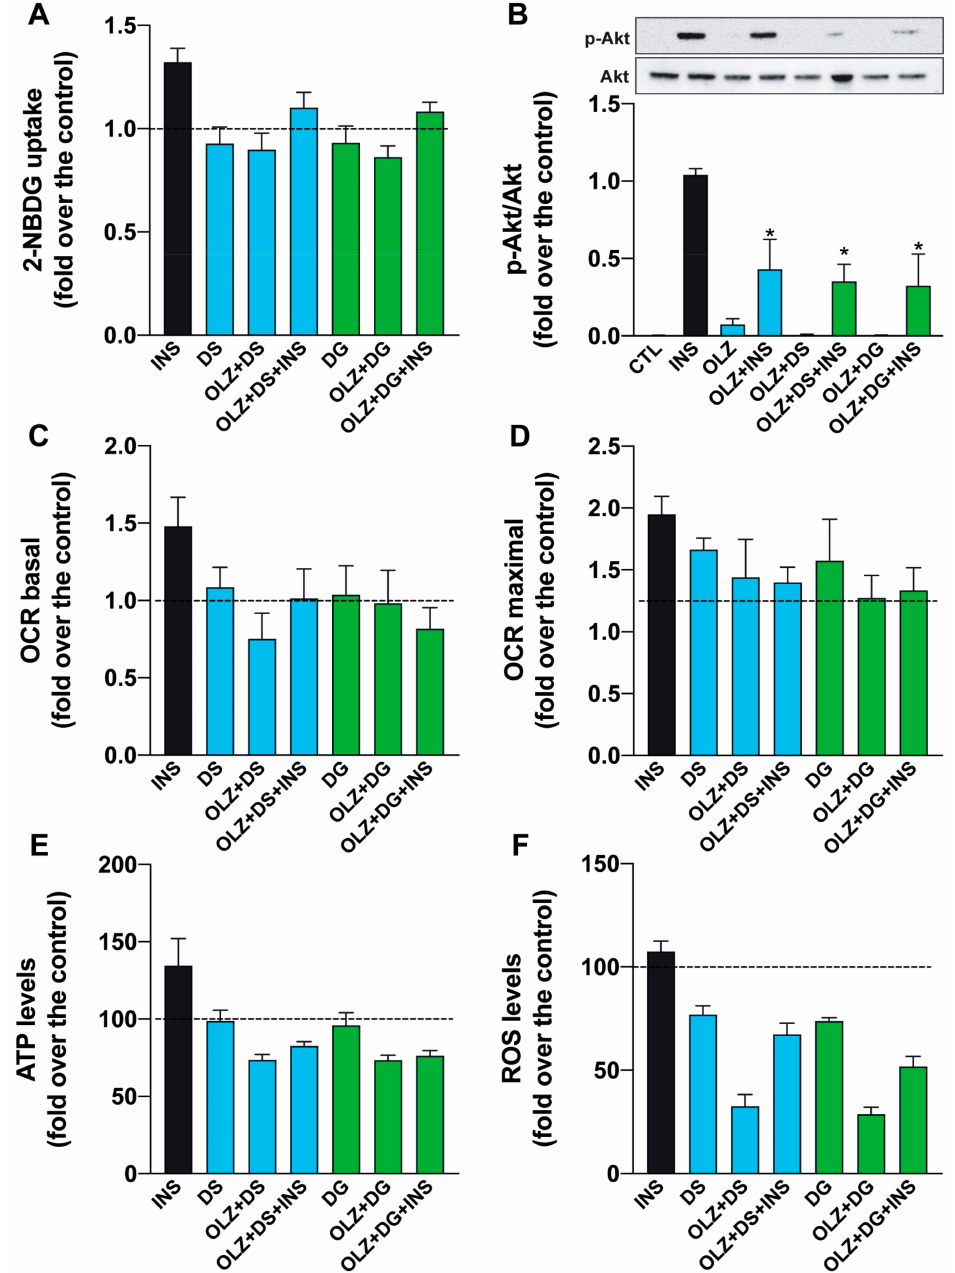
Figure 5. Effect of anthocyanins (DS and DG) co-incubated with OLZ after insulin response in L6 myoblasts. ( A ) Glucose uptake was measured after 24-h OLZ treatment in the presence (+) or absence (-) of DS or DG. Glucose uptake only increased in control cells (no treatment) after 30 min of a single 100 nM insulin stimulus (black bar). ( B ) Akt phosphorylation was determined by Western blot and normalized by total Akt to quantify differences among the conditions. OLZ treatment decreased p-Akt in response to insulin, and DS and DG co-incubation with OLZ did not restore phosphorylation levels. Mitochondrial metabolism: ( C ) Basal oxygen consumption rate (OCR) increased in L6 cells after insulin 100 nM stimuli (black bar), and incubation with anthocyanins (DS blue bars and DG green bars) decreased insulin response. ( D ) Maximal OCR was determined after the addition of FCCP to uncouple oxidative phosphorylation. ( E ) ATP levels were significantly decreased in the presence of OLZ and could not be rescued by DS or DG. ( F ) ROS production was significantly decreased after incubation with OLZ and was not restored after incubation with anthocyanins. * p < 0.05 vs. CTL. Dotted line represents the control condition with no stimuli (before insulin